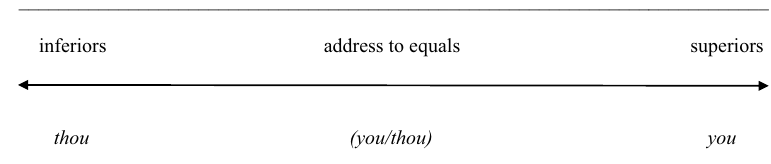
Figure 1: The axis of social